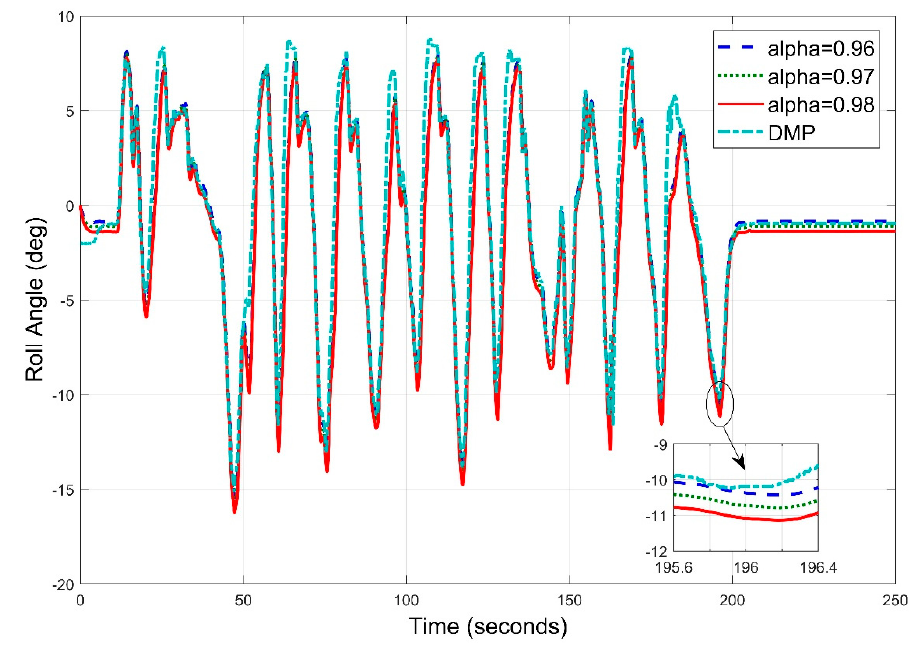
Figure 23. Real time roll angle estimate at f = 20 Hz for complementary filter .